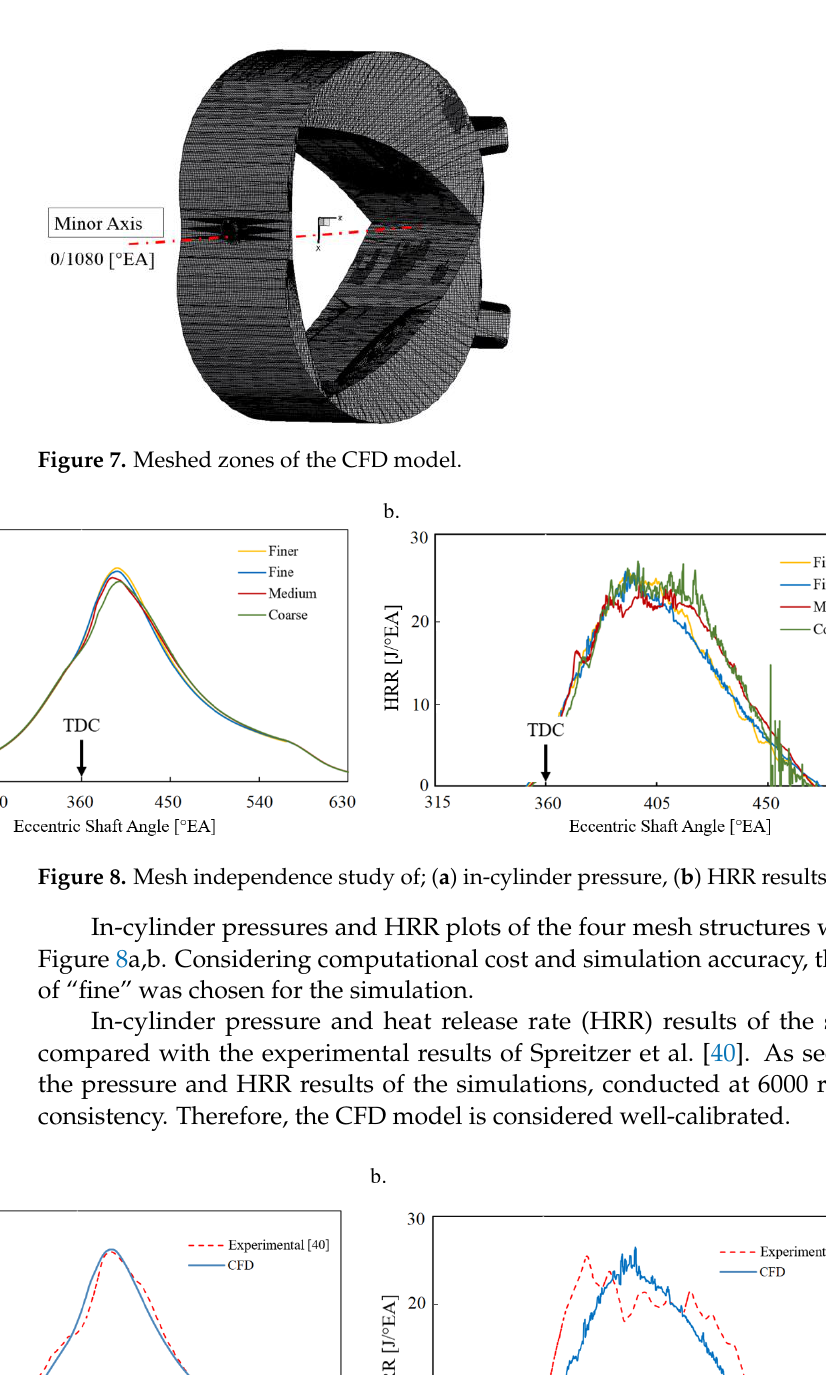
Figure 9. Validation of the CFD model with the experimental results. ( a ) Pressure, ( b ) HRR results versus eccentric shaft